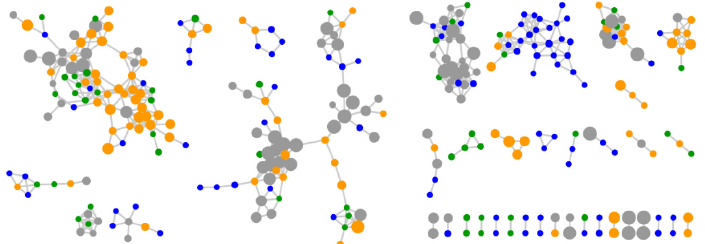
Figure 5. Molecular network with 315 parent ions produced by ten Bacullus licheniformis strains. Nodes representing ions produced by strains isolated from Scotland (KP30, KP30, KP56, KP62, KP93) and Antarctica (KP120, KP121, KP126, KP126, KP128) are green and blue, respectively. Nodes representing parent ions produced by strains isolated from both Scotland and Antarctica are orange and media components are grey. The node size reflects the number of strains that produce each parent ion from the smallest node (strain specific) to the largest node (10 strains).